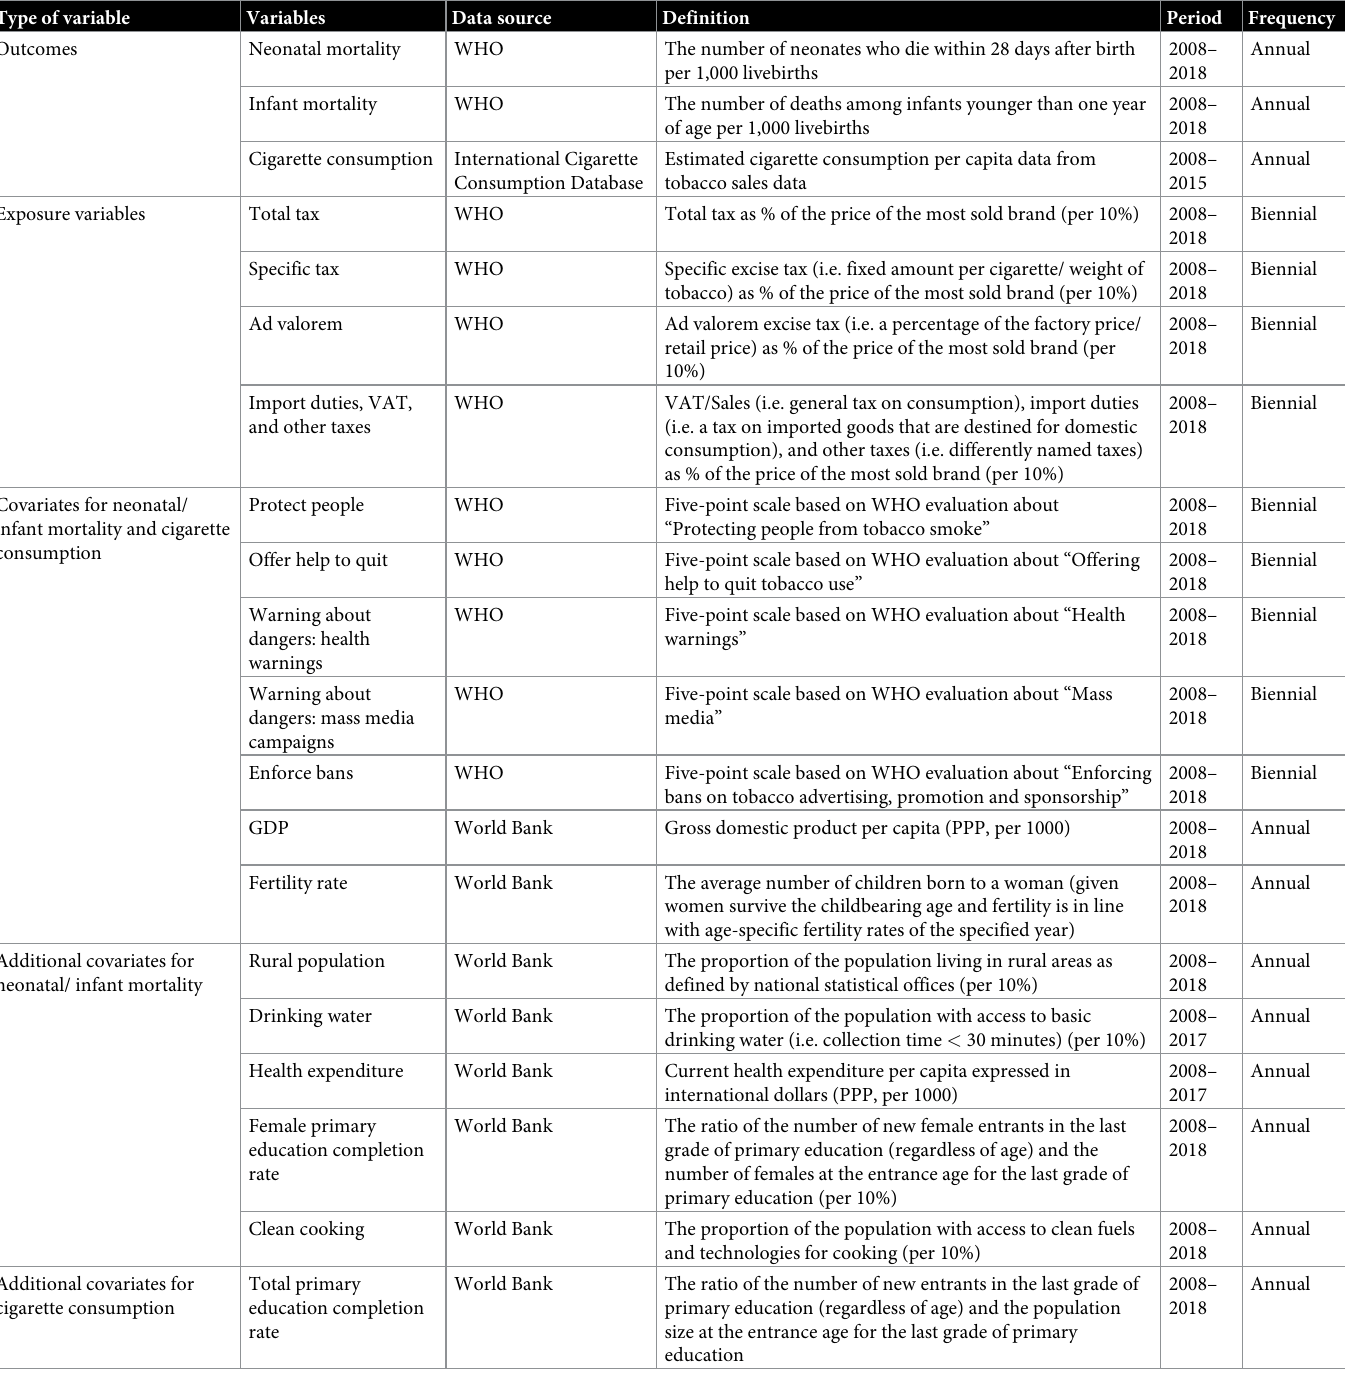
Table 1. Description of the included